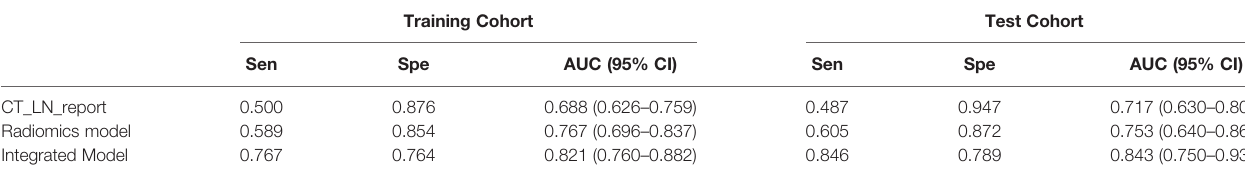
TABLE 2 | Diagnostic ef fi ciency of the CT_LN_report, Radiomics Model, and Integrated Model in the training and test cohorts. Training Cohort Test